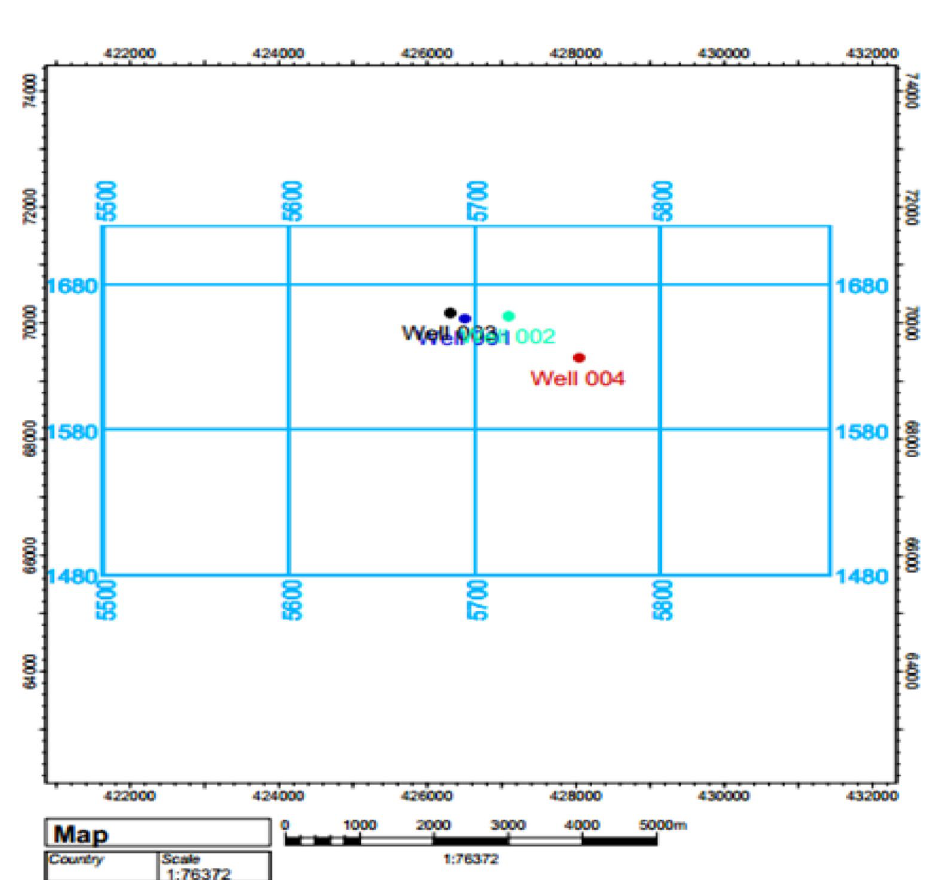
Fig. 1 Base map of the study location. The base of the study location indicates the actual well locations within the study area and the corresponding